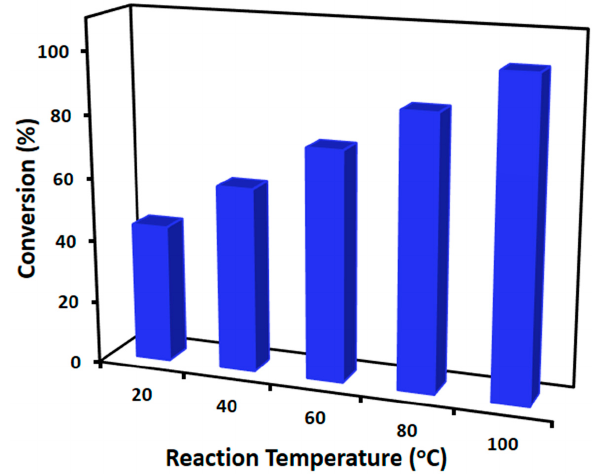
Figure 8 . Catalytic activity of ZnO x (1%)–MnCO 3 /(1%)HRG catalyst as a function of reaction temperature.